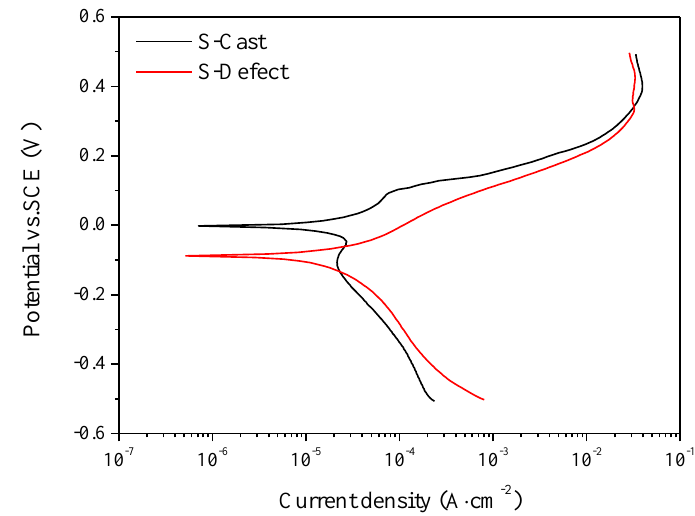
Figure 10. The polarization curve of S-Cast and S-Defect. Table 5. Corrosion parameters of S-Cast and S-Defect.